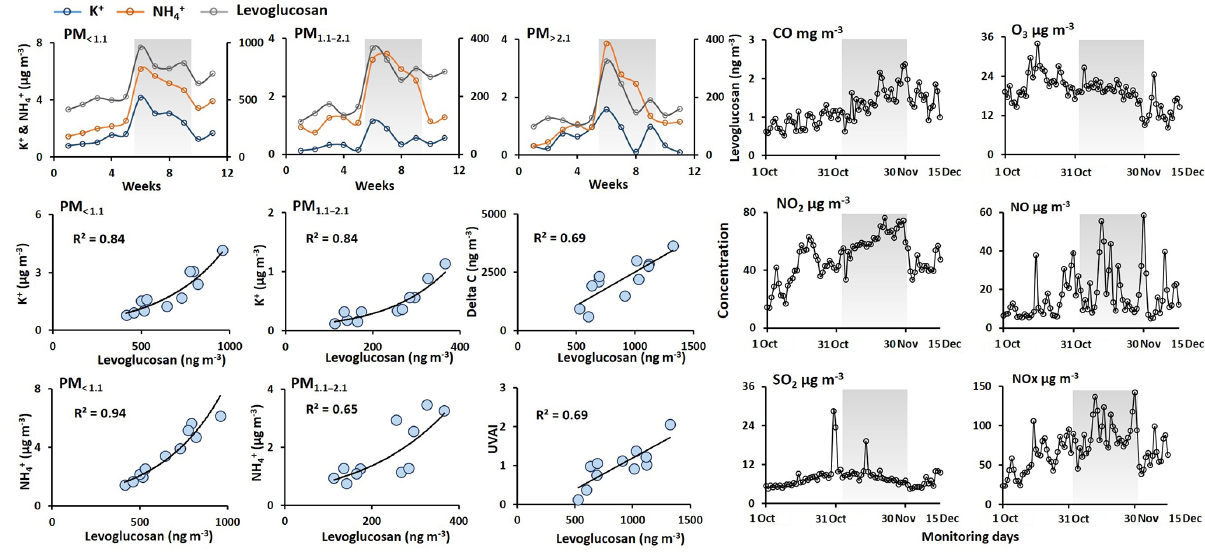
Figure 6. Temporal variation in trace gases and biomass burning signature molecules (NH + different aerosol size